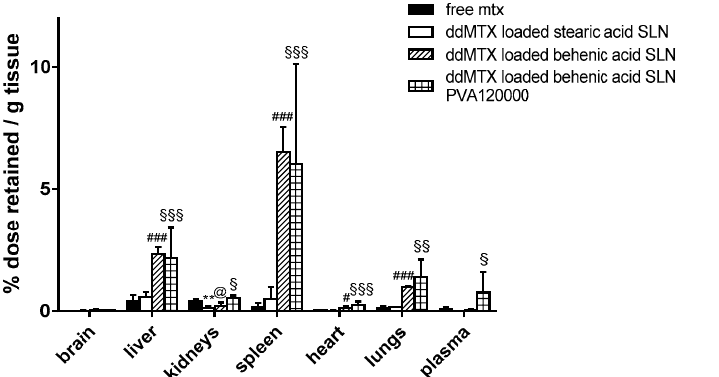
Figure 1. Biodistribution of the unfunctionalized ddMTX-loaded SLNs and free MTX (sacrifice 30 min after administration). Statistical analysis: ddMTX-loaded SLNs vs. free MTX; stearic acid SLNs < MTX: p < 0.005 **; behenic acid SLNs < MTX: p < 0.05 @; behenic acid SLNs > MTX: p < 0.05 #, p < 0.001